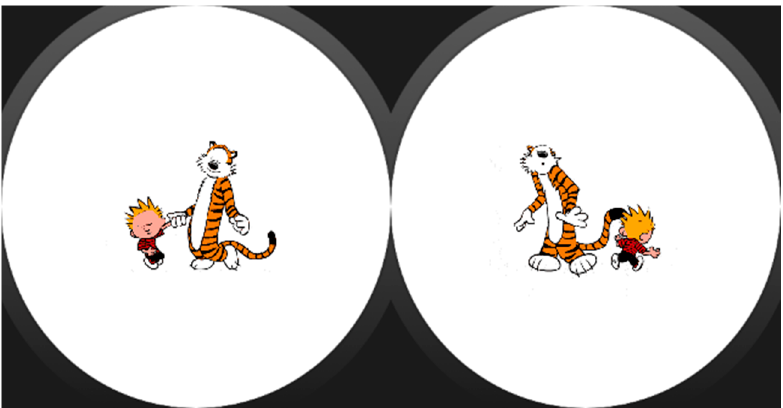
Figure 3. Animated GIF in the smartwatch screen.